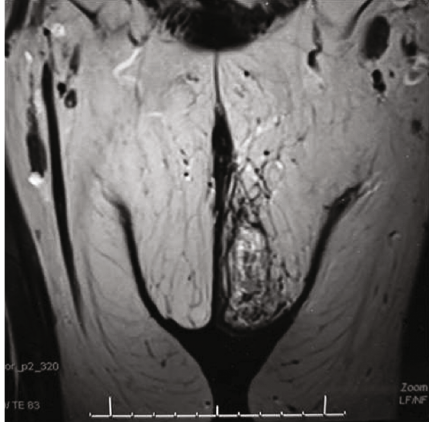
Figure 2: MRI showing an empty cavity without any collection. Skin in fi ltration with suspicion of a cellulitis. Absence of fi stula.